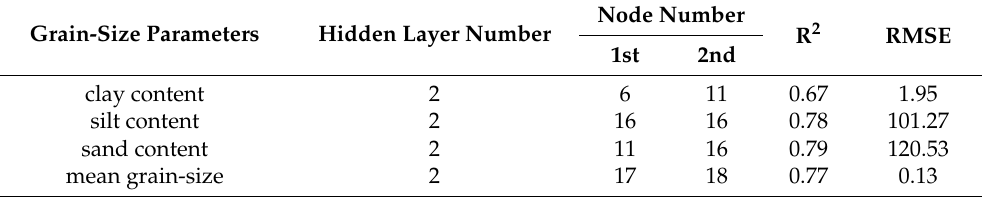
Figure 13. Validation results of the optimal BPNN model for clay ( a ), silt ( b ), sand ( c ), and mean grain-size ( d ). Table 4. Optimal node number combinations and calibration accuracies of BPNN